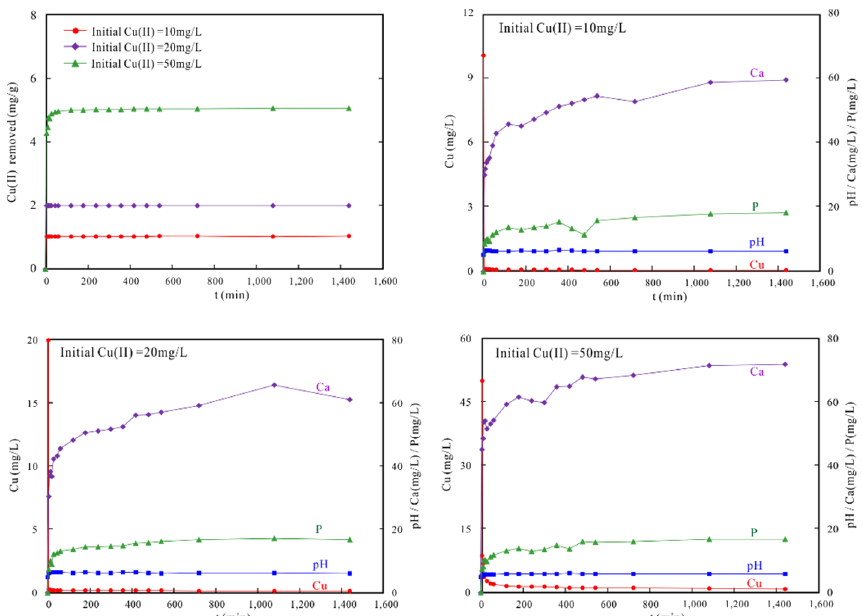
Figure 6. Influence of interaction time on Cu (II) removal by SC–HA/C (initial pH 5.0; SC–HA/C dose 0.5 g/50 mL; SC–HA/C particle size < 100 mesh; 25 °C).